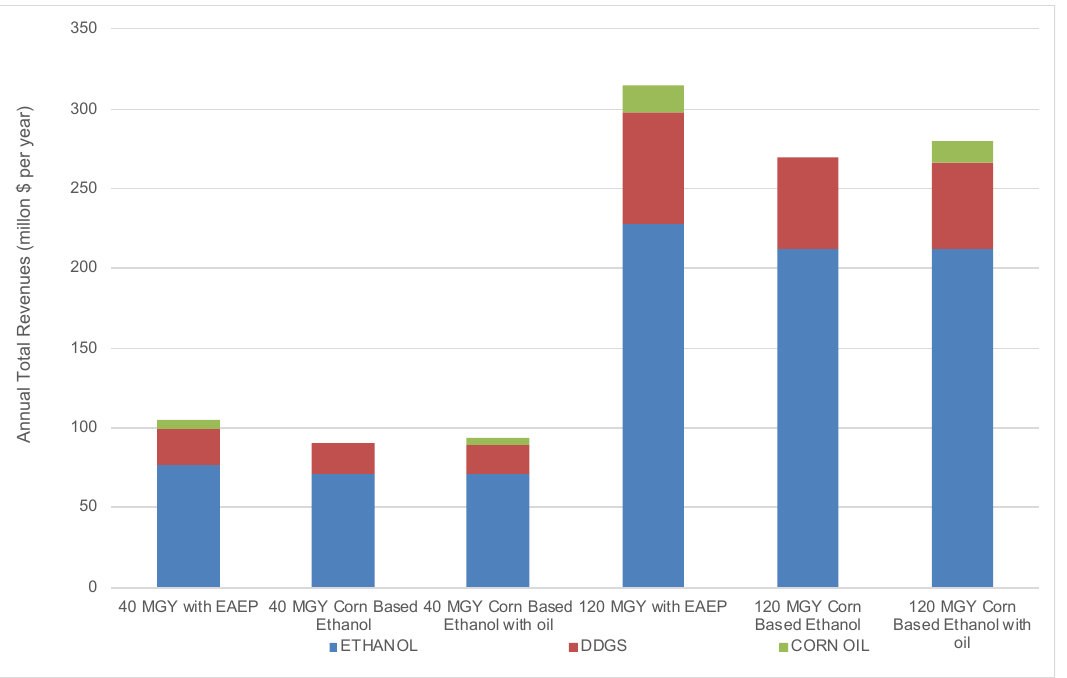
Figure 5. Annual total revenues for integrated corn-soy ethanol fermentation processing. Scenarios include a 40 million gallon per year (MGY) ethanol plant with or without corn oil separation, a 120 MGY ethanol with or without corn oil separation, and a 40 or 120 MGY ethanol plant, without corn oil separation but with EAEP products used for fermentation.